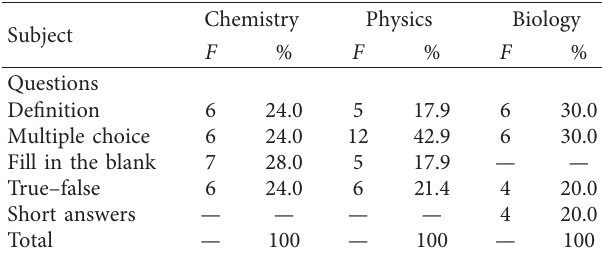
Table 8: Final examinations’ frequency distribution of substantive questions for chemistry, physics, and biology.